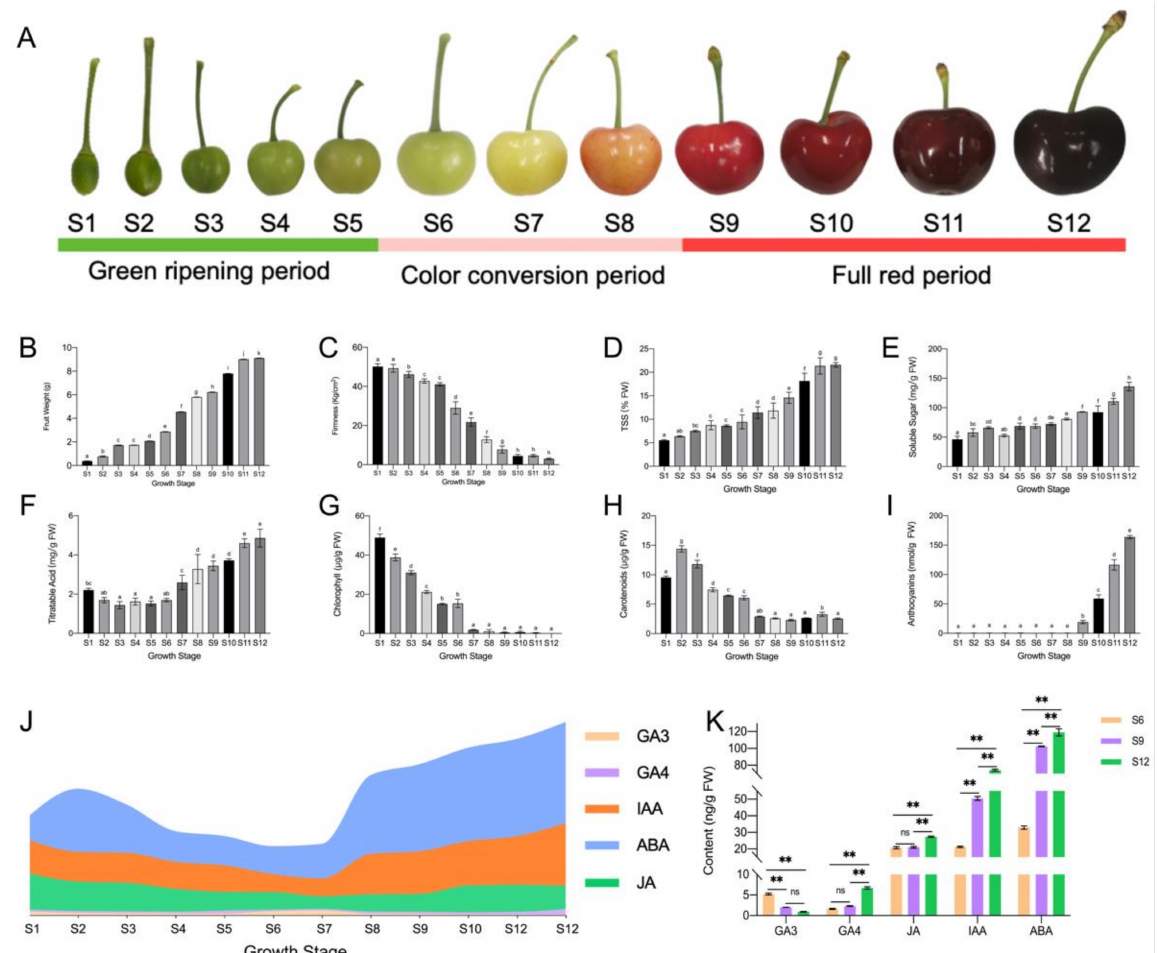
Figure 1. Changes in fruit quality and endogenous hormones during the development of sweet cherries. ( A ) Fruit growth and development status diagram; ( B ) single fruit weight, in which different lowercase letters indicate significant differences ( p ≤ 0.05), the same below; ( C ) fruit firmness; ( D ) fruit soluble solids (TSS) content; ( E ) fruit soluble sugar content; ( F ) fruit titratable acid content; ( G ) fruit chlorophyll content; ( H ) fruit carotenoid content; ( I ) fruit anthocyanin content; ( J ) hormone profile during fruit development; ( K ) the specific changes in fruit endogenous hormones in the three periods of S6, S9, and S12, where ns means insignificant, and ** indicates an extremely significant correlation at the 0.01